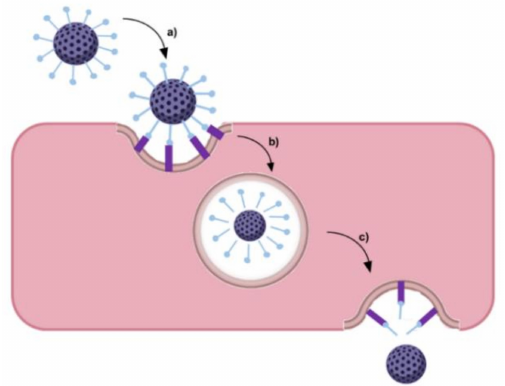
Figure 7. Schematic representation of separation of the NPs from the Tf–TfR complex in the acidic endo/lysosomal compartment: ( a ) ligand-modified NP recognizes and binds to the TfR; ( b ) NP separated from the Tf-TfR complexes in the endosome; and ( c ) NP’s endosomal escape followed by